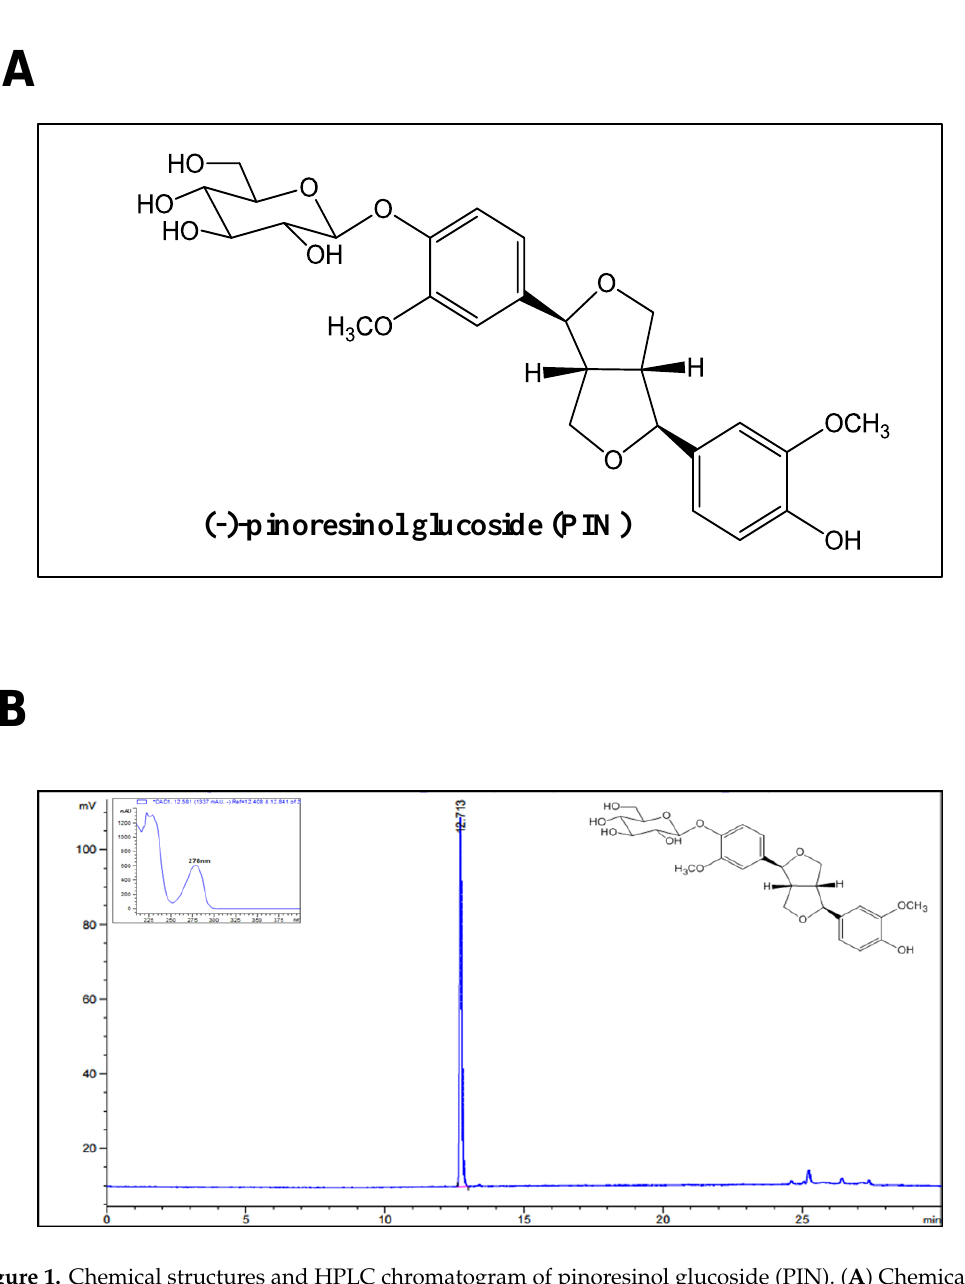
Figure 1. Chemical structures and HPLC chromatogram of pinoresinol glucoside (PIN). ( A ) Chemical structure of PIN from stem bark of Styrax japonica . ( B ) HPLC chromatogram of